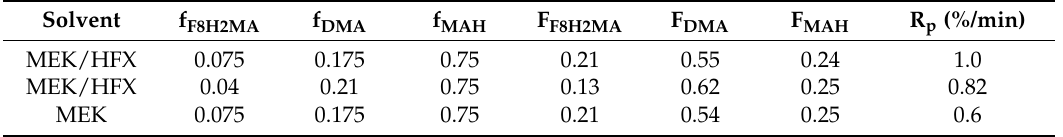
Table 8. P(DMA- co -F8H2MA- co -MAH). Monomer composition in the feed and copolymer composition and the initial reaction rates at low conversion.